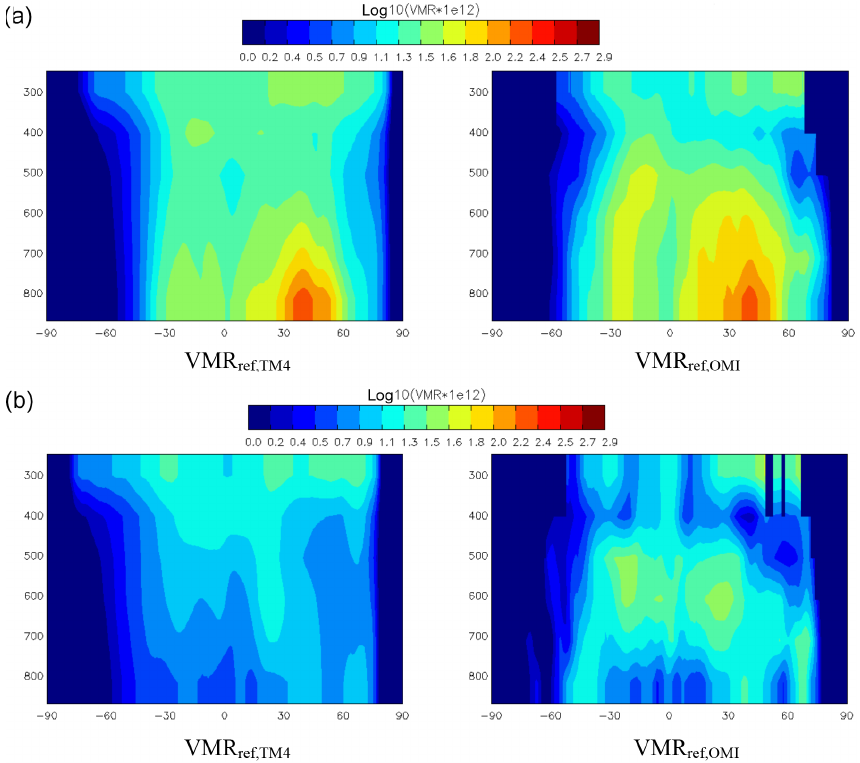
Figure 10. (a) Latitude–height cross section of annual zonal mean tropospheric NO 2 VMR in logarithmic scale from TM4 (left) and OMI (right) with CRF > 50%. (b) Same as (a) but for the remote Pacific sector (180–135W).